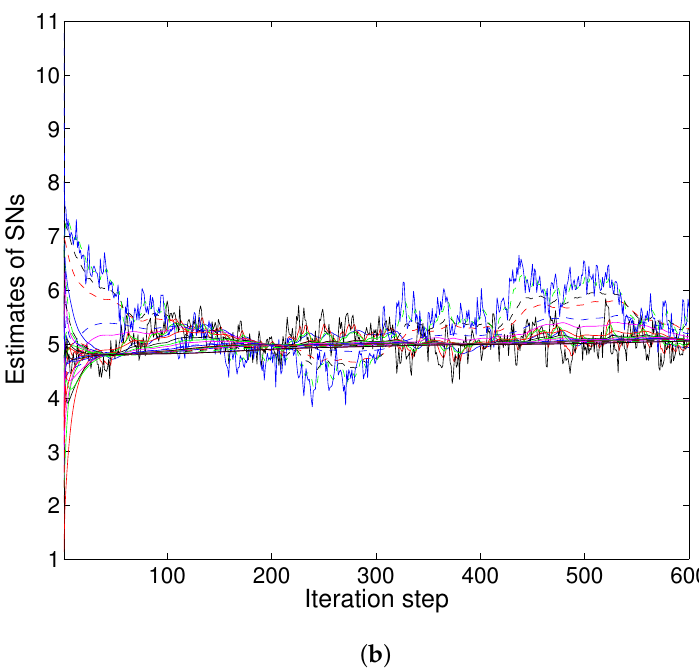
Figure 6. Convergence of Olfati in numerical example 2: ( a ) without attackers; ( b ) with three